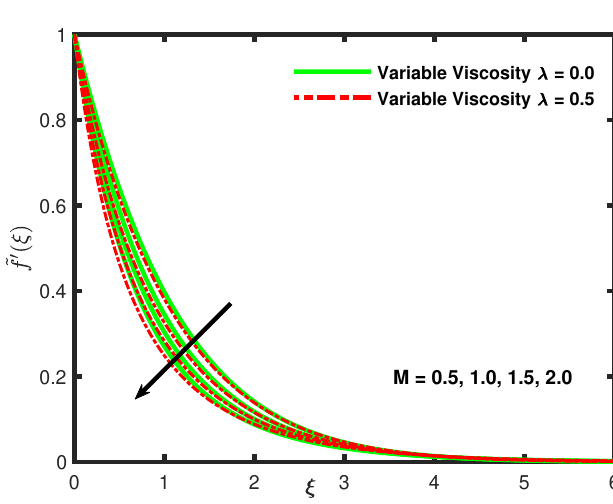
Figure 2. The influence of Magnetic penetrability ( M ) on Velocity